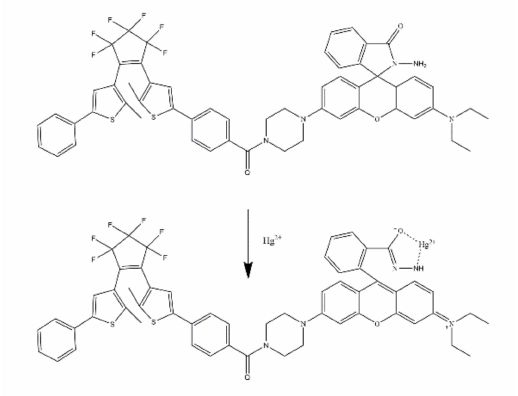
Figure 8. The possible sensing mechanism of RhB (Table 1, No. 9) to Hg 2+ [41]. Li, X., et al. synthesized a fluorometric and colorimetric chemosensor, named 1O and studied its responses for Hg 2+ (Table 1, No. 10). The results suggested that Hg 2+ induced remarkable colorimetric and fluorescent changes, due to the reaction between 1O and Hg 2+ (Figure 9). Singh S., et al. described a rhodamine-based fluorescence sensor for Hg 2+ detection in water samples (Table 1, No. 11) [43]. The influences of different analytical parameters on the analytical performance of the sensors were discussed. Results showed that replacing the fluorophore of rhodamine B with rhodamine 6G on the prepared sensor improved the limit of detection. In addition, the buffer optimization improved detection limits and selectivity. The prepared sensor was successfully applied for Hg 2+ detection in tap and river samples.